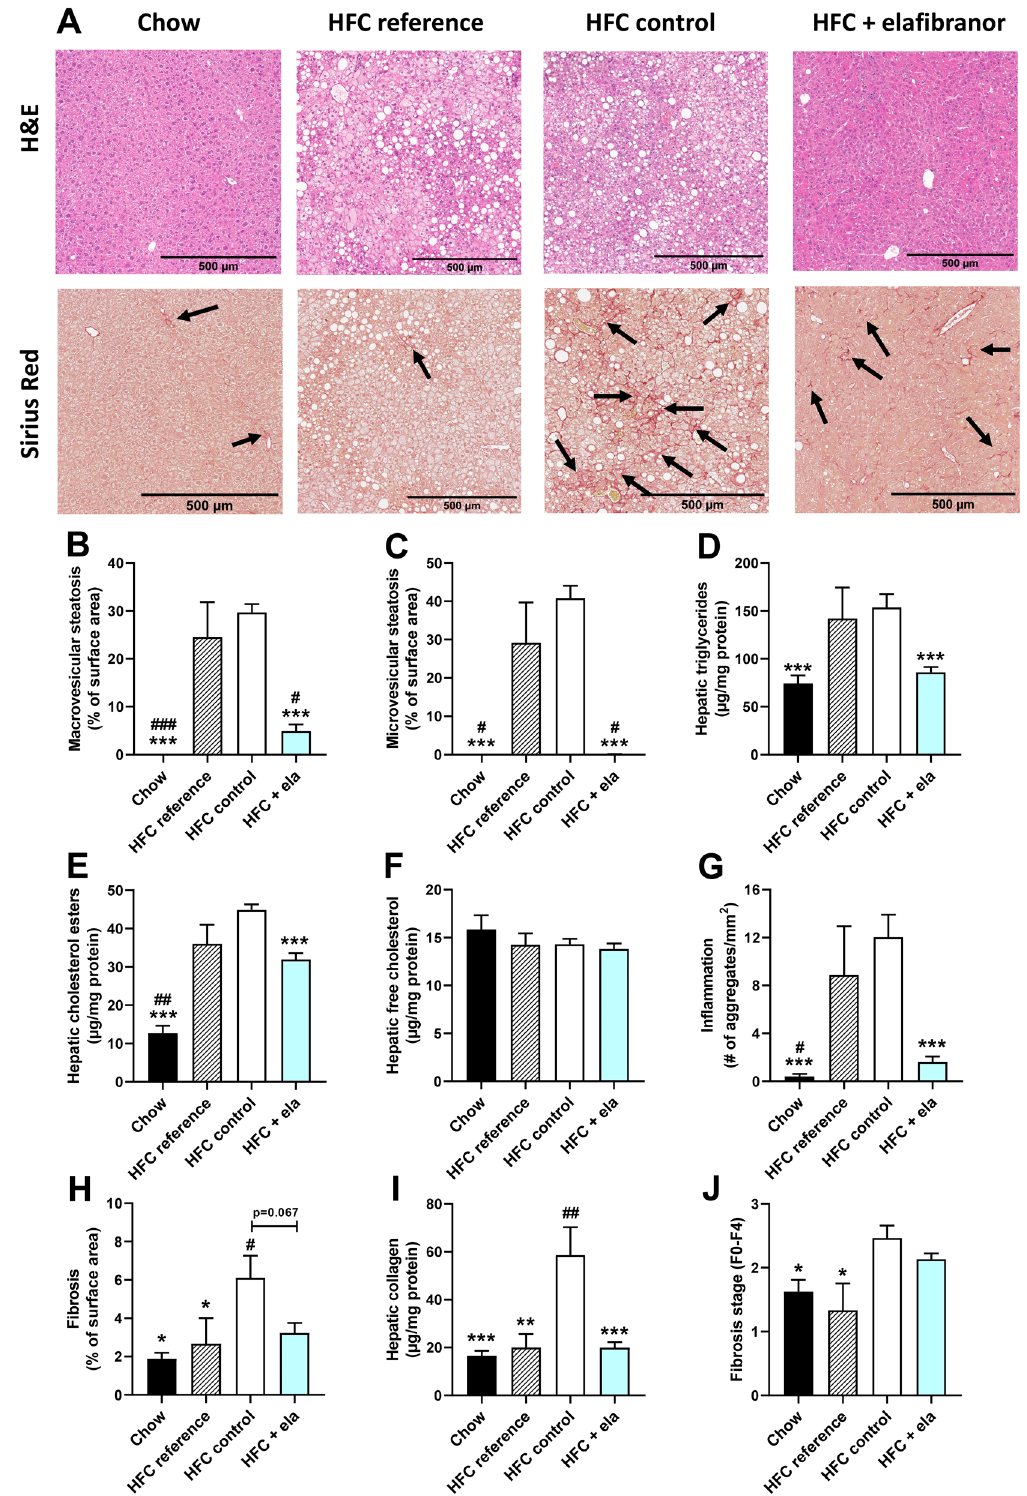
Figure 2. Histological photomicrographs and quantitative analysis of NASH in E3L.CETP mice. Representative images of liver cross sections stained with hematoxylin and eosin (H&E) or Sirius Red (arrows indicate collagen depositions) (A) and quantitative analysis ( B – I ) from E3L.CETP mice fed a healthy chow diet or fed a HFC diet for 15 weeks and left untreated or treated with 15 mg/ kg/d elafibranor (ela) for 10 weeks. Macrovesicular (B) and microvesicular (C) steatosis as percentage of total liver area, biochemically analysed hepatic triglycerides ( D ), cholesterol esters ( E ) and free cholesterol ( F ), inflammation as number of inflammatory aggregates per mm 2 microscopic field ( G ), hepatic fibrosis as percentage Sirius Red of surface area ( H ) or biochemically analysed hepatic collagen ( I ) and hepatic fibrosis stage ( J ). Values represent mean ± SEM for n = 8 chow mice, n = 6 HFC reference mice and n = 15 HFC control or HFC + elafibranor treated mice. * p < 0.05, ** p < 0.01 and *** p < 0.001 vs. HFC control; # p < 0.05, ## p < 0.01 and ### p < 0.001 vs. HFC